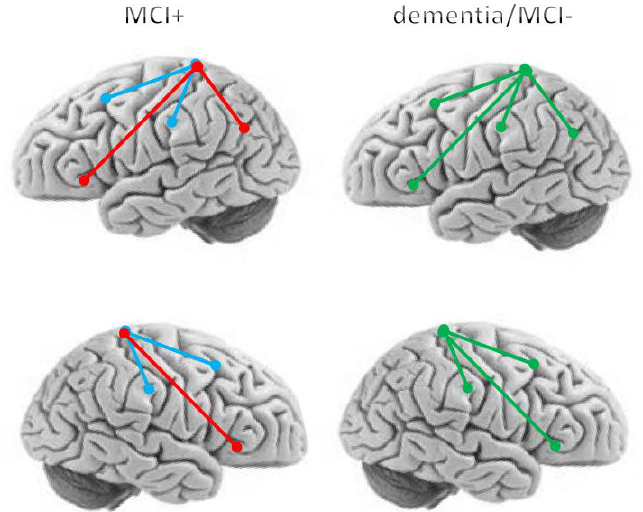
Figure 2. Changes in resting-state functional connectivity from pre- to post-iTBS. The brains plot only the significant changes in cortico-cortical connectivity induced by iTBS within left and right hemispheres (from the top to bottom). Red, blue, and green colors of the spheres (the Euclidean centers of the regions of interests (ROIs)) and lines (voxel connections) indicate the direction (increase, decrease, and no changes, respectively) of connectivity changes as induced by real iTBS. Patients with dementia and Mild Cognitive Impairment (MCI)- showed no changes in connectivity as induced by real iTBS. Subgroups are pooled together as there were not significant differences between VaD and AD, aMCI and naMCI, and AD/VaD and MCI-. Sham iTBS yielded no effects.